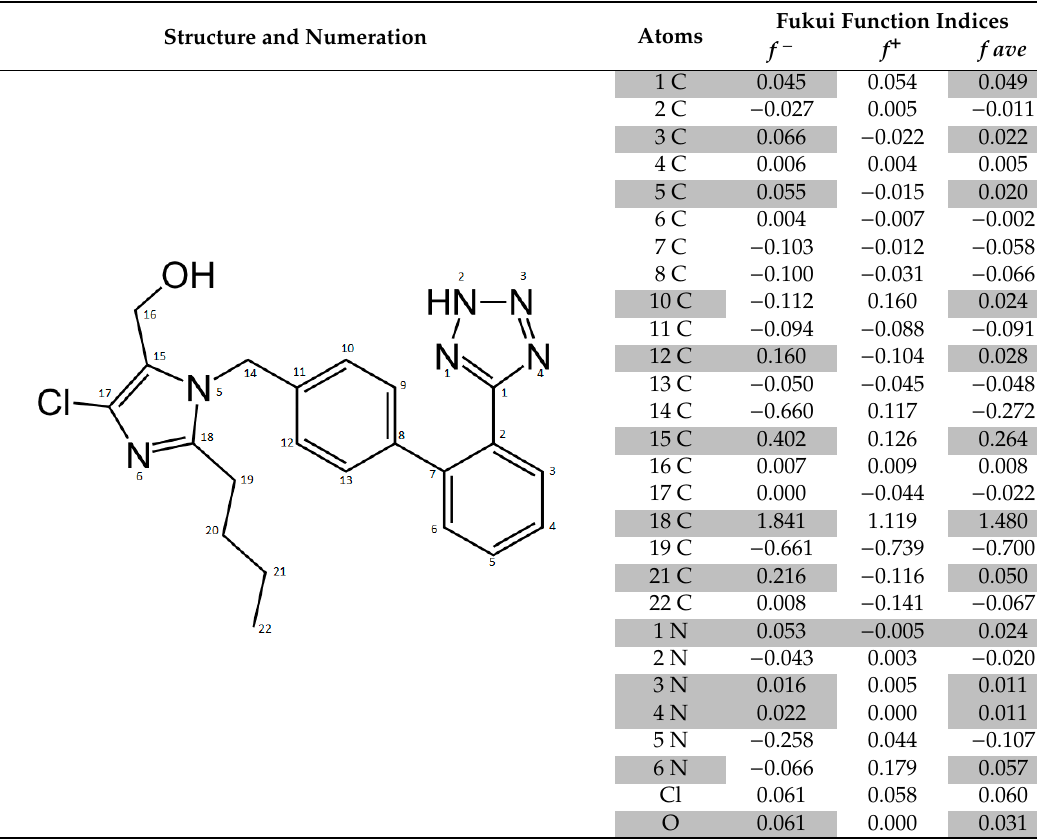
Table 3. Results of computational analysis for losartan 1 .